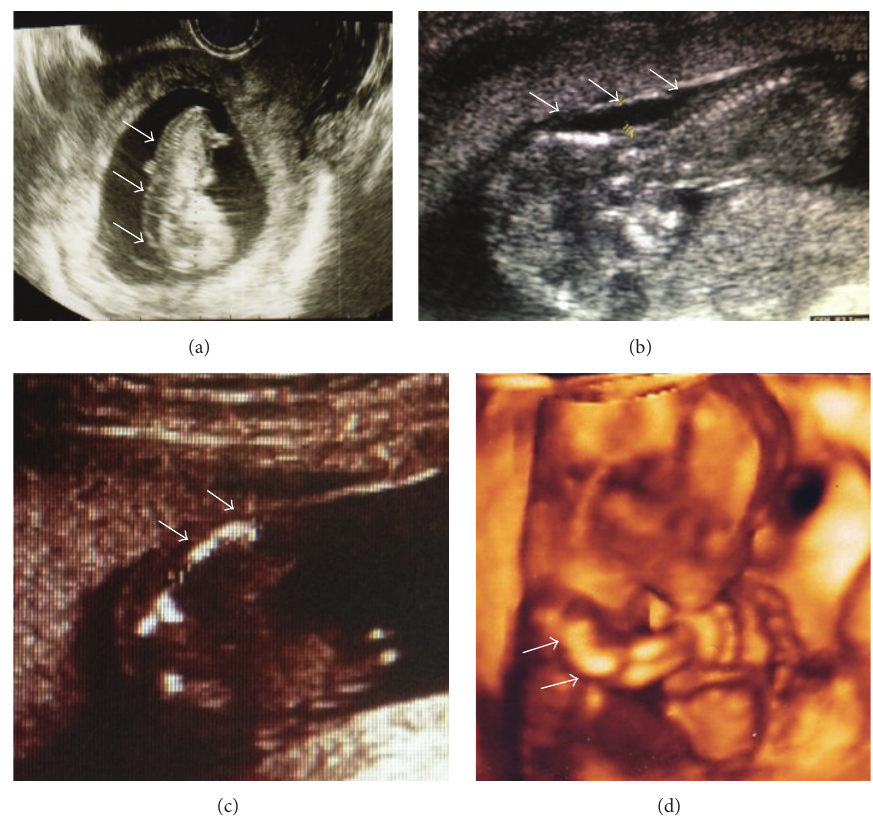
Figure 1: Fetal ultrasound with skin edema in the posterior part of the head and vertebral column ( → ) (a). A longitudinal view of the head and the thorax demonstrating skin edema in the posterior part of the neck ( → ), macrocephaly, and narrow thorax (b). Fetal ultrasound showing short curved femur ( → ) (c). A three-dimensional image with a view of the upper limbs showing bowed humerus ( → )